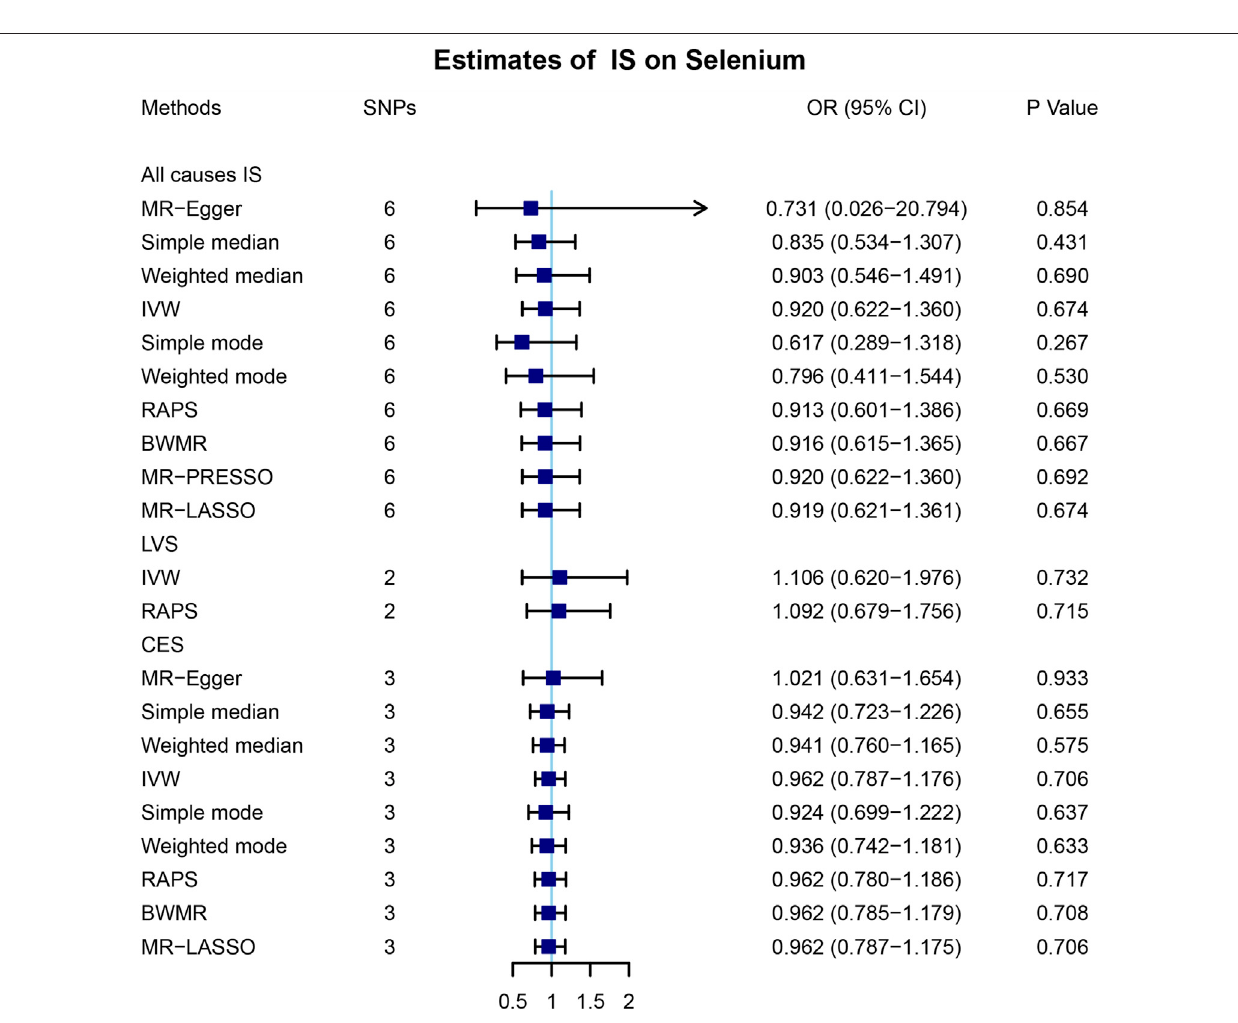
TABLE 3 | Sensitivity analysis of ischemic stroke and selenium